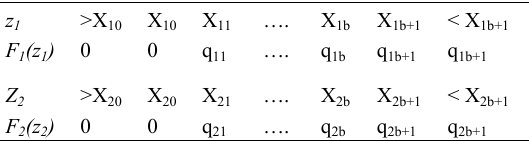
Table 1. Membership function of f i (z i )